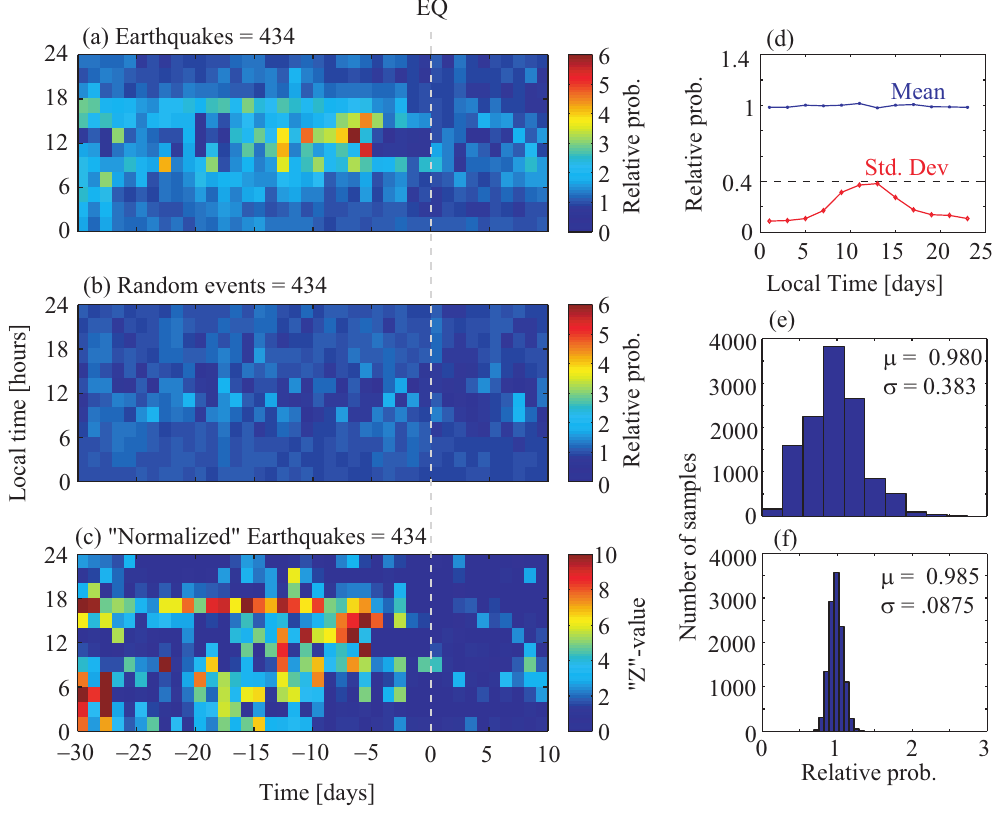
Fig. 4. Significance test of Pc1 observations. (a) Relative probability of observing Pc1 pulsations with respect to earthquakes, (similar to Fig. 3d), (b) same as (a) with respect to 434 random events, (c) normalized relative probability (d) mean and standard deviation of random statistical sample, (e) histogram plot of random event distribution for LT=12:00–14:00 (highest variance), and (f) same as (e) for LT=00:00–02:00 (lowest